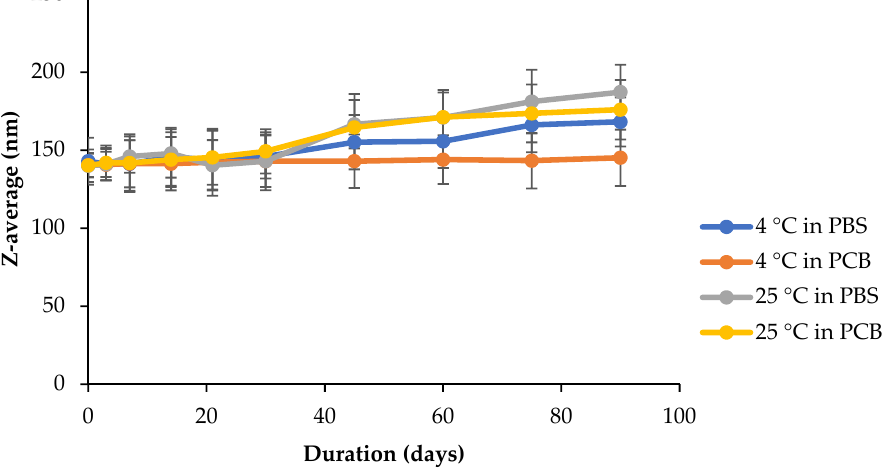
Figure 11. Hydrodynamic diameter of α -arbutin-loaded BMO-PUL NPs dispersed (2 mg/mL) in either phosphate-citrate buffer (pH 5) or phosphate-buffered saline (pH 7) at varying temperatures (4 or 25 °C) for 90 days ( n = 3; ± SD).